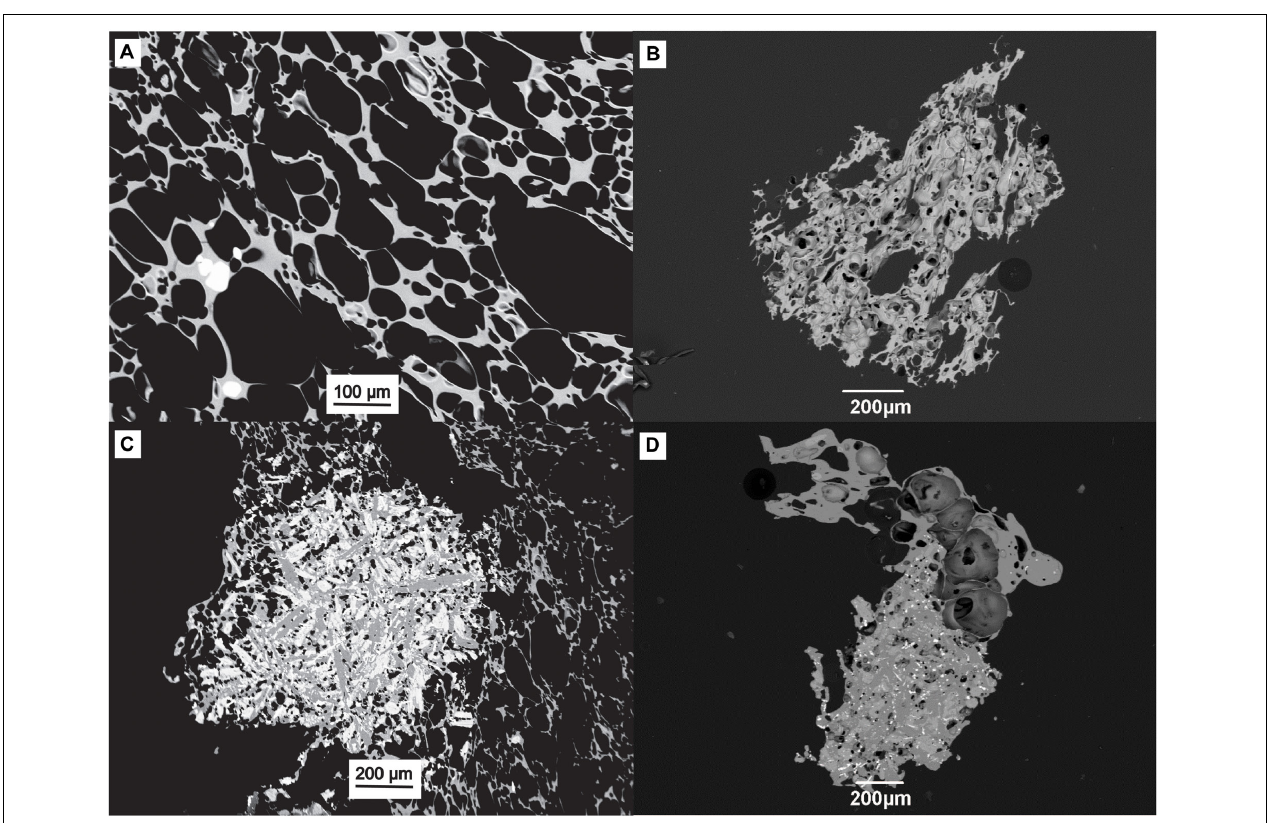
FIGURE 4 | Representative samples [lapilli (A,C) and ash (B,D) ] from outcrops B and C, showing highly vesicular and almost aphyric trachytic pumice textures (A,B) and magmatic mafic enclaves (MME) of microcrystalline trachybasalt (C,D) in ash grains with low aspect ratio